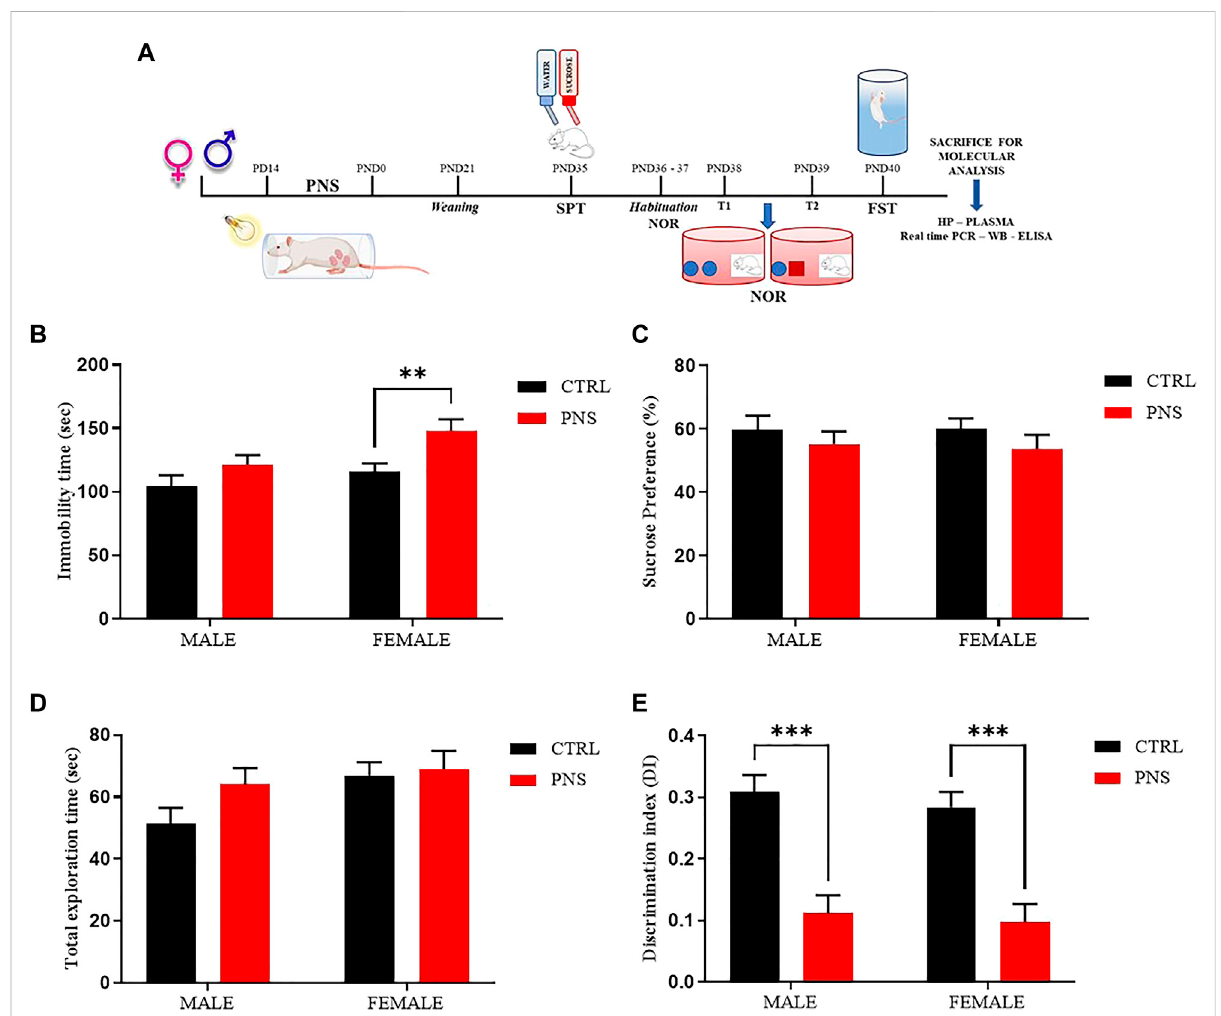
PNS induces depressive-like behavior and recognition memory de fi cits in adolescent rats. (A) Schematic representation of the experimental design. CTRL = Control, PNS = Prenatal Stress, PD = Pregnancy Day, PND = Post Natal Day, SPT = Sucrose Preference Test, NOR = Novel Object Recognition, FST = Forced Swim Test, Real time-PCR = Real time-Polymerase Chain Reaction, WB = Western Blot, ELISA = Enzyme-linked immunosorbentassay,and HP=Hippocampus. (B) Depressive-likebehaviorassessedintheFSTbymeasuring immobility time (sec)inPNSand CTRL rats. ** p < 0.01 vs. CTRL female. (C) Sucrose preference (%) of CTRL and PNS males and female rats. (D) Total Exploration Time and (E) DiscriminationIndex(D.I)wereusedtoevaluaterecognitionmemoryinrats.*** p <